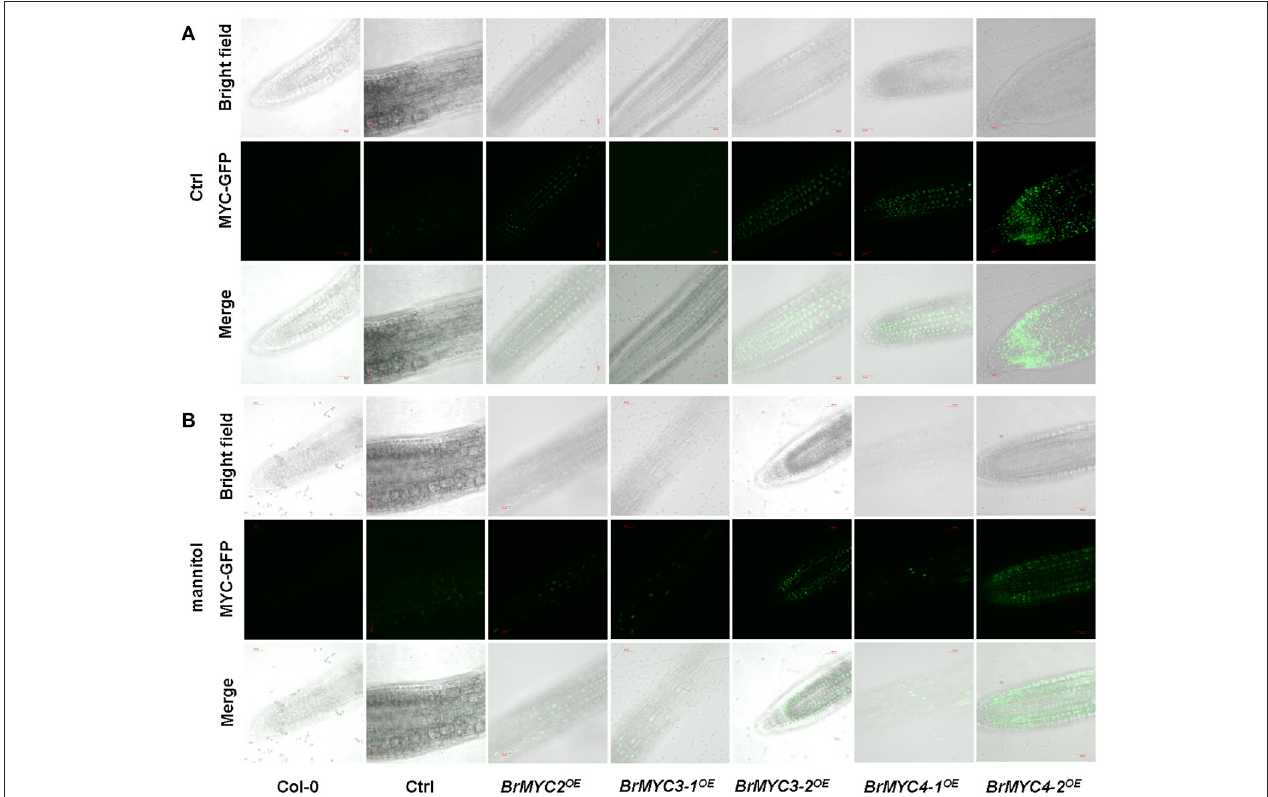
FIGURE 3 | Green fluorescent protein (GFP) in the root tip of transgenic Arabidopsis , BrMYC2/3/4-GFP localizes to the nucleus. (A,B) Confocal images show the presence of BrMYC2/3/4-GFP fluorescence at the edges of root cells of 5-day-old transgenic Arabidopsis seedlings without (A) or with (B) plasmolysis induced by 1M mannitol treatment for 5min. Top panels, bright-field images; middle panels, fluorescence images of MYC-GFP; bottom panels, merged bright-field and fluorescence images. Bar = 30 µ m.